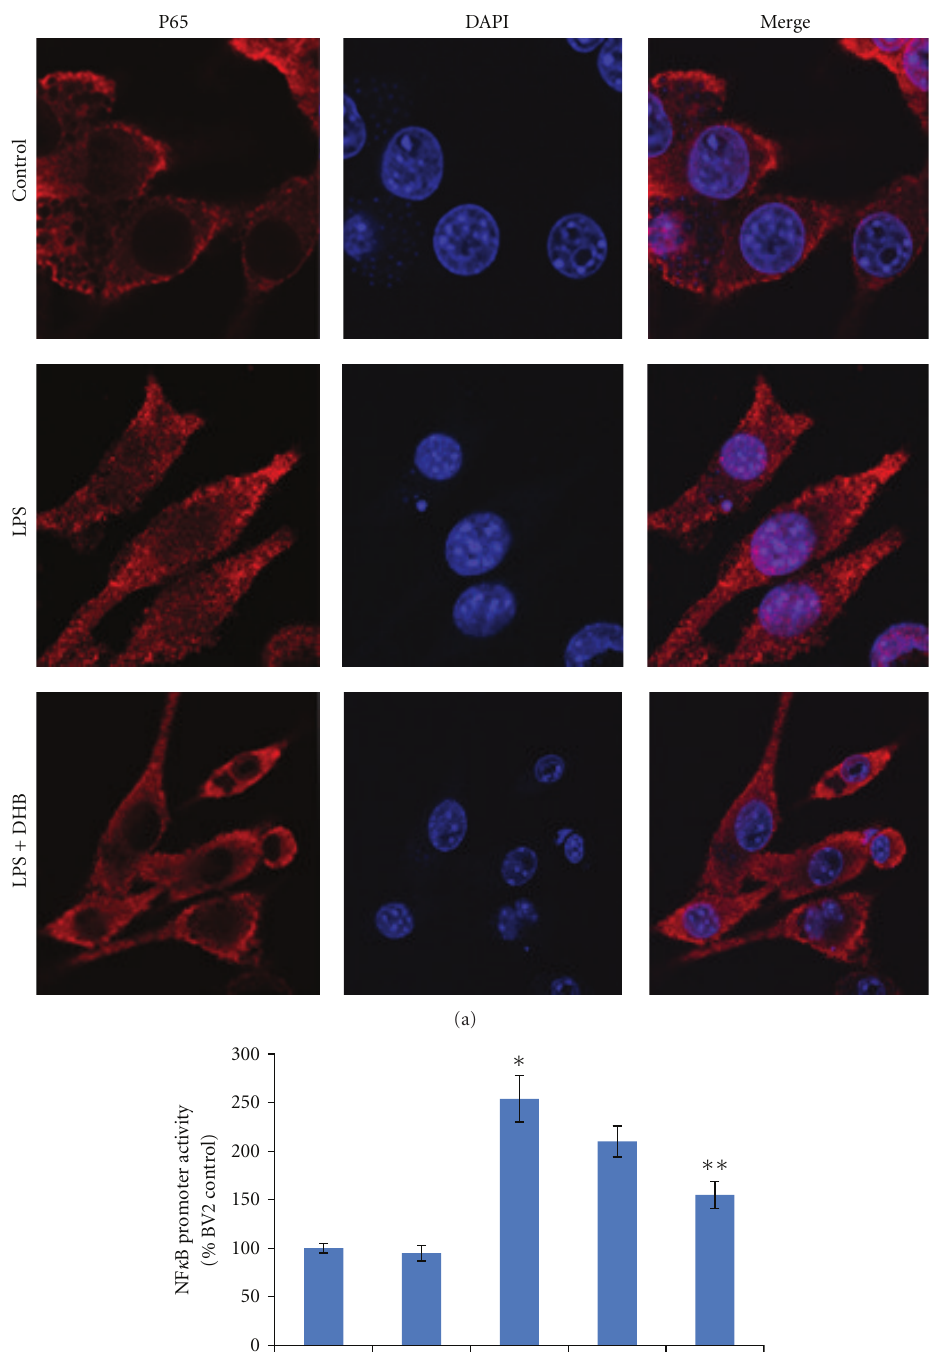
Figure 4: (a) After pretreatment with DHB (100 μ M) for 1h, BV2 cells were stimulated with 100 ng/mL LPS for 1h and nuclear translocation of the NF κ B p65 subunit assessed by confocal fluorescence microscopy using a fluorescent anti-p65 antibody. Representative laser confocal microcopy images of p65 (red stain) and nuclear DAPI staining (blue) in cells exposed to LPS ± DHB are shown; pink, merged. (b) BV2 cells were transiently transfected with NF κ B-Luc for 24h and treated with 100 ng/mL LPS for 4h ± DHB for 1h. Cell lysates were assayed for luciferase activity (mean ± SE, n = 4). ∗ P < 0 . 05 versus control, ∗∗ P < 0 . 05 versus